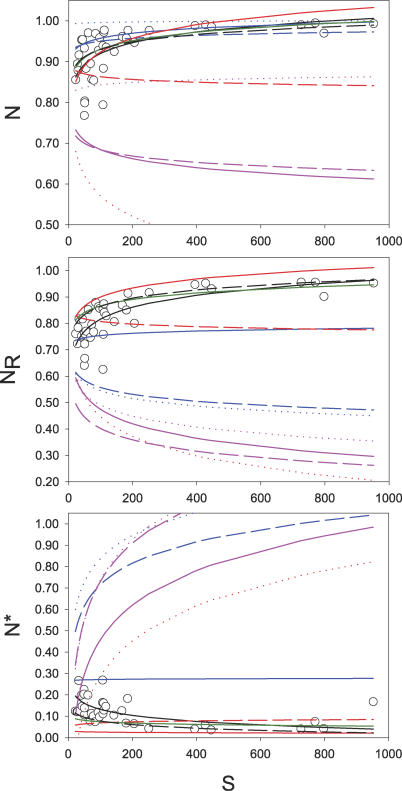
Nestedness of Networks of Increasing Size (S) for Real-World and Modelled Data MatricesCircles indicate real-world data (N = 37), the continuous black line indicates an empirical fit to real-world data, and the broken black line is the result of lognormal-neutral models. Colour lines indicate the fits to modelled data sets: narrow-range complementarity models are red, broad-range complementarity models are magenta, barrier models are blue, and mixed models are green. Dotted lines indicate one-trait models, broken lines indicate two-trait models, and continuous lines indicate four-trait models. NR (random matrices). N*, relative nestedness (N/NR)